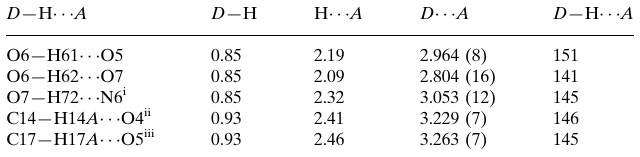
Hydrogen-bond geometry (A˚ , (cid:3)